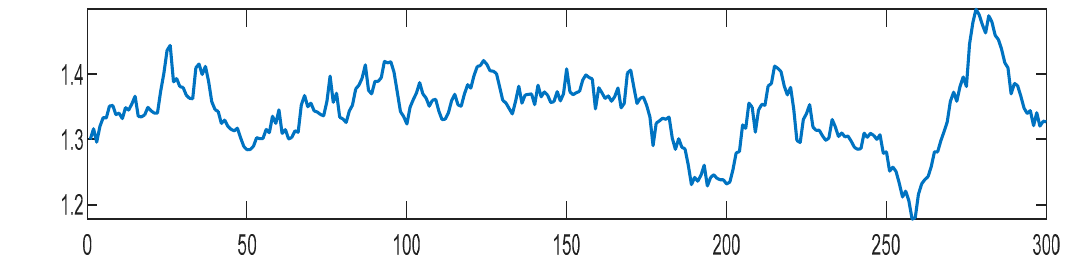
Figure 14. Selected constant mean value scenario of gas prices.